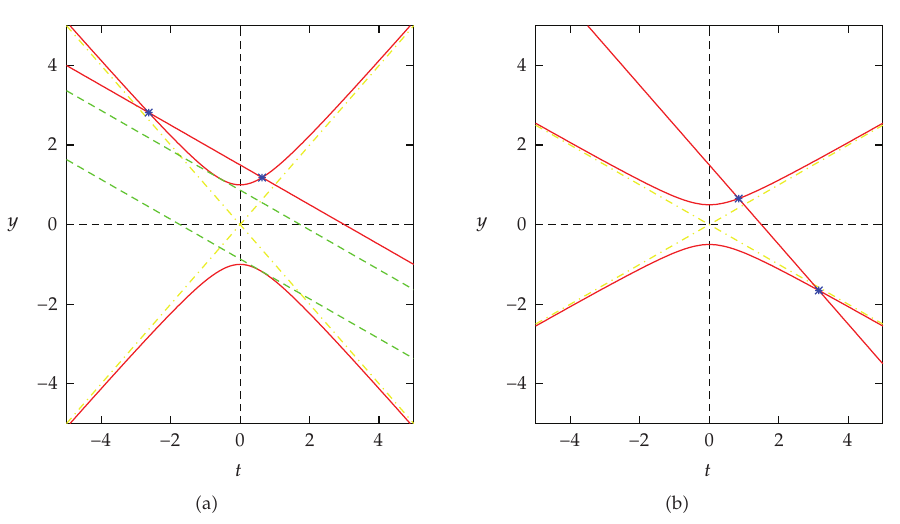
√ Figure 10: Functions y (cid:7) ± s t 2 (cid:6) 1 (cid:2) red lines (cid:3) , their asymptotes (cid:2) yellow (cid:3) , and the straight line y (cid:7) p − qt (cid:2) red (cid:3) versus t , for (cid:2) a (cid:3) p (cid:7) 1 . 5, q (cid:7) 0 . 5 < s (cid:7) 1 and (cid:2) b (cid:3) q (cid:7) 1 > s (cid:7) 0 . 5. In (cid:2) a (cid:3) also the tangent lines at ! s 2 − q 2 are drawn with green lines. Intersection points are marked with blue p (cid:7) ±